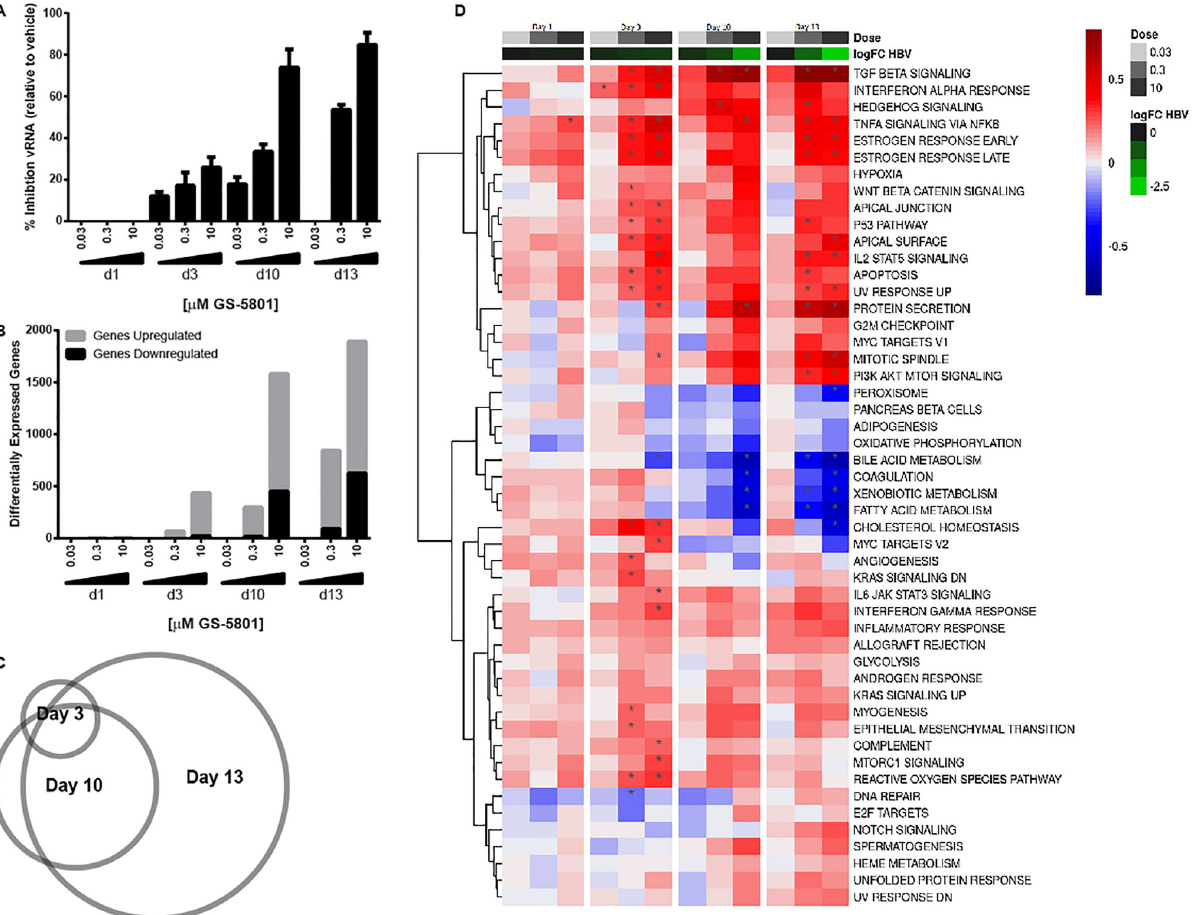
Fig 6. GS-5801 influences host and viral gene transcription. PHH from three donors (8130, 8181, and 4239) were infected with HBV for three days prior to initiation of GS-5801 treatment. PHH were treated continuously with vehicle, 0.03, 0.3, or 10 μ M GS-5801 every three to four days for a total of 13 days. PHH were harvested at 1, 3, 10, and 13 days after initiation of GS-5801 dosing and mRNA was quantified by RNA-seq. (A) The number of sequencing reads mapping to the HBV genome were quantified in all samples (counts per million; cpm) and data are plotted as the percentage inhibition of HBV RNA (vRNA) in GS-5801 treated samples relative to vehicle treated samples at each timepoint. (B) The number of genes differentially up or downregulated (differential by 4-fold log 2 ; FDR < 0.05) in GS-5801 treated PHH compared to vehicle treated PHH are shown for each timepoint. (C) Shown is a Venn diagram demonstrating the overlap of the identity of genes differentially upregulated (fold change � 4-fold log 2 ; FDR < 0.05) in PHH treated with 10 μ M GS-5801 compared to vehicle treated PHH for Day 3 (n = 414 genes), Day 10 (n = 1131 genes), and Day13 (n = 1268 genes) after initiation of GS-5801 dosing. (D) Hallmark Gene Set. Data are displayed as the difference in average gene set score based on GSVA between each dose respective vehicle control, with upregulated gene sets in red and downregulated gene sets in blue. For comparison, downregulation of HBV mRNA for same dose and time regiment is shown at the top.